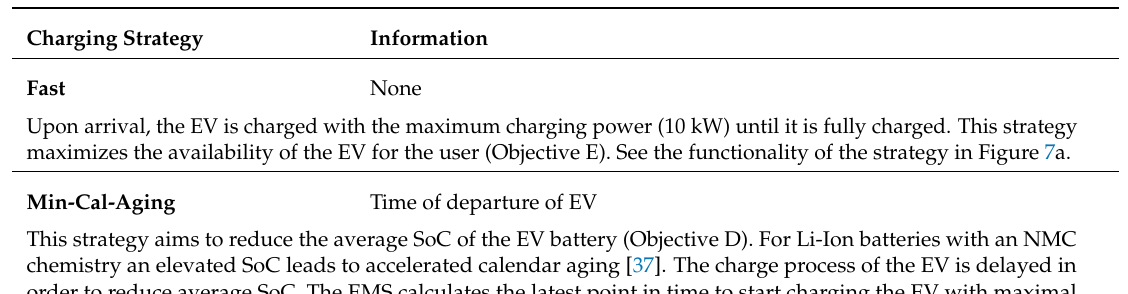
Table 4. Description of simulated charging